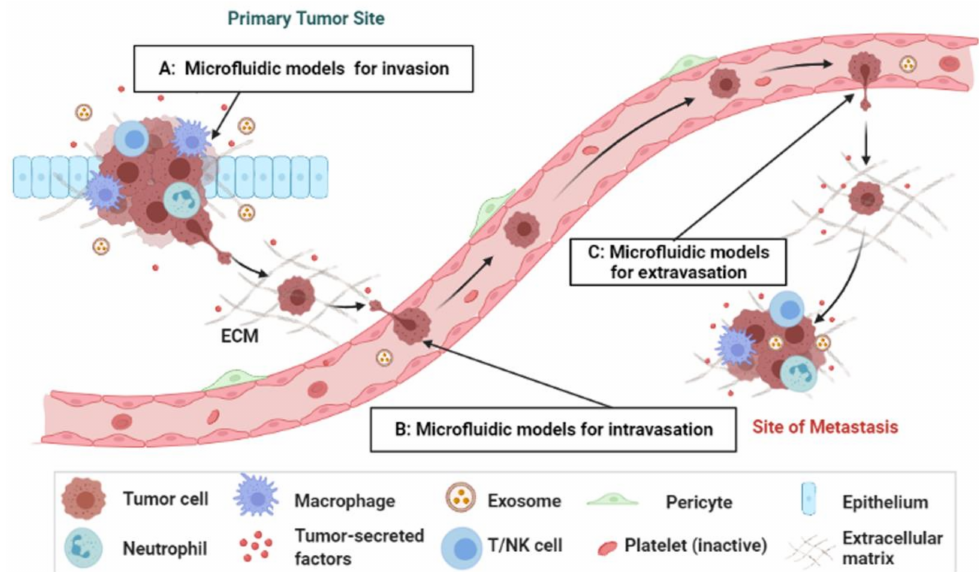
Figure 1. Microfluidic models involving metastatic steps described in this paper. ( A , B ) Inva- sion/intravasation process and ( C ) extravasation